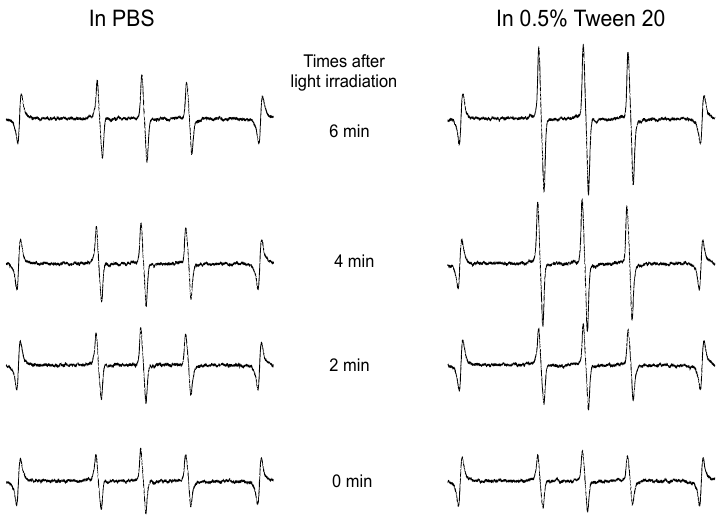
Figure 4. Electron Spin Resonance (ESR) spectra of HA-es-ZnPP in phosphate-buffered saline (PBS) in the presence/absence of Tween 20 under light irradiation. 1 O 2 generation from HA-es-ZnPP was captured by 4-oxo-TEMP, and triplet 4-oxo-TEMP signal as the indicator of 1 O 2 was detected by ESR spectra. In the presence of Tween 20, a relatively high level of 1 O 2 generation was observed in an irradiation time-dependent manner, whereas no 1 O 2 generation occurred in PBS without Tween 20, in which HA-es-ZnPP behaves as micelles.